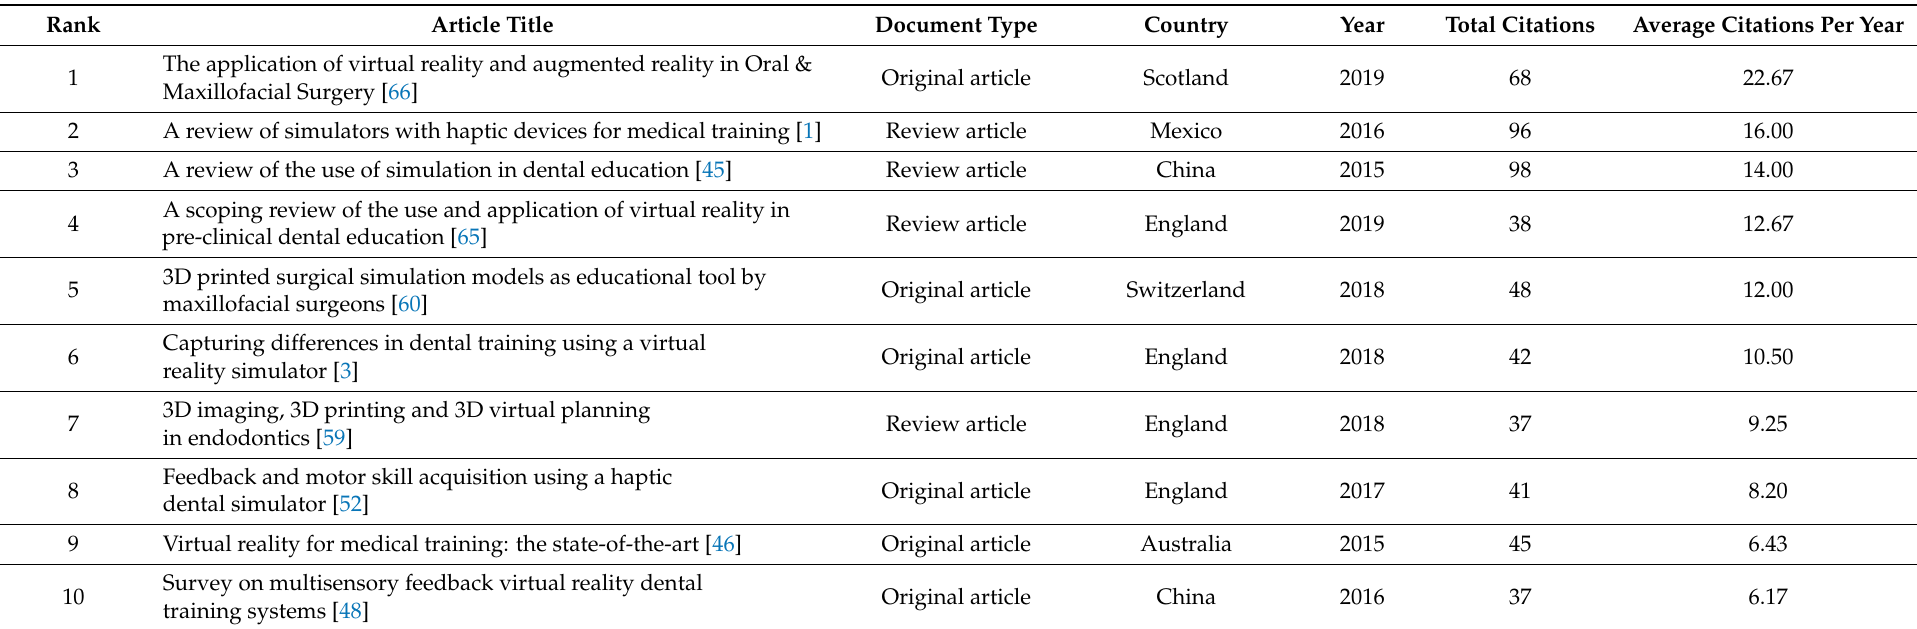
Table 3. The top 10 most-cited articles based on the average citations pre